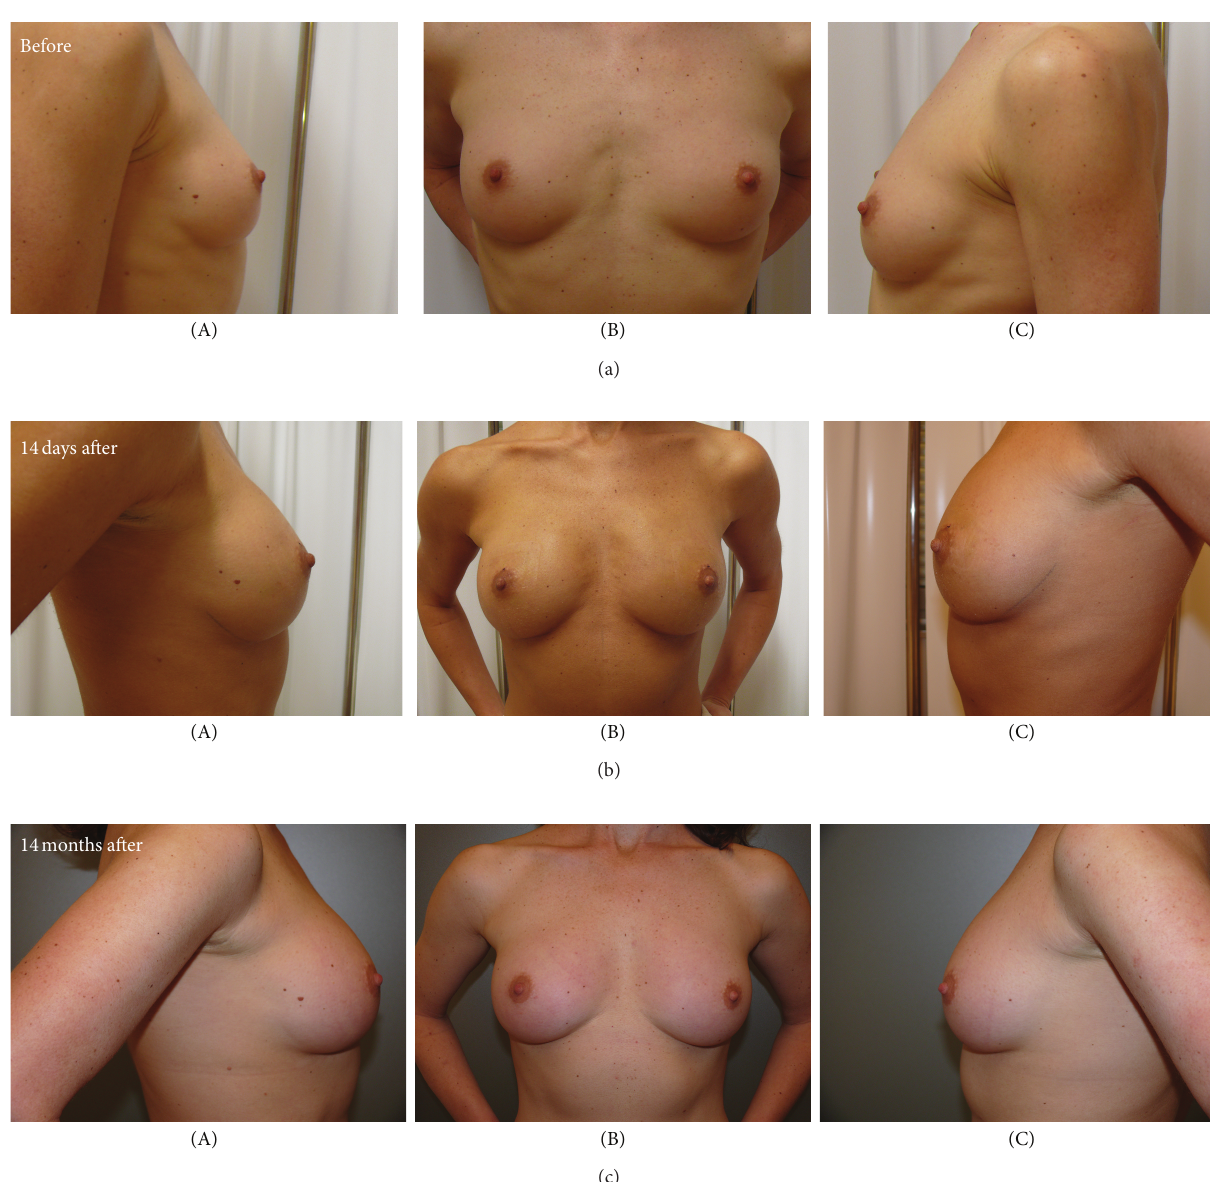
Figure 4: Clinical outcomes and aesthetic results after BMMNCs-enriched lipograft for primary bilateral breast augmentation: preoperative views (top), and postoperative views at 14 days (middle), postoperative views at 12 months (bottom); (A) right view, (B) front view, and (C) left